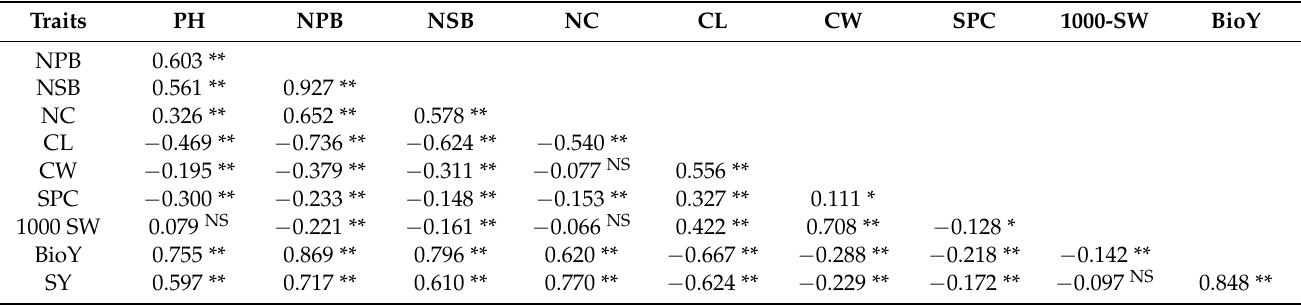
Table 3. Correlation coefficients among the agronomic traits of